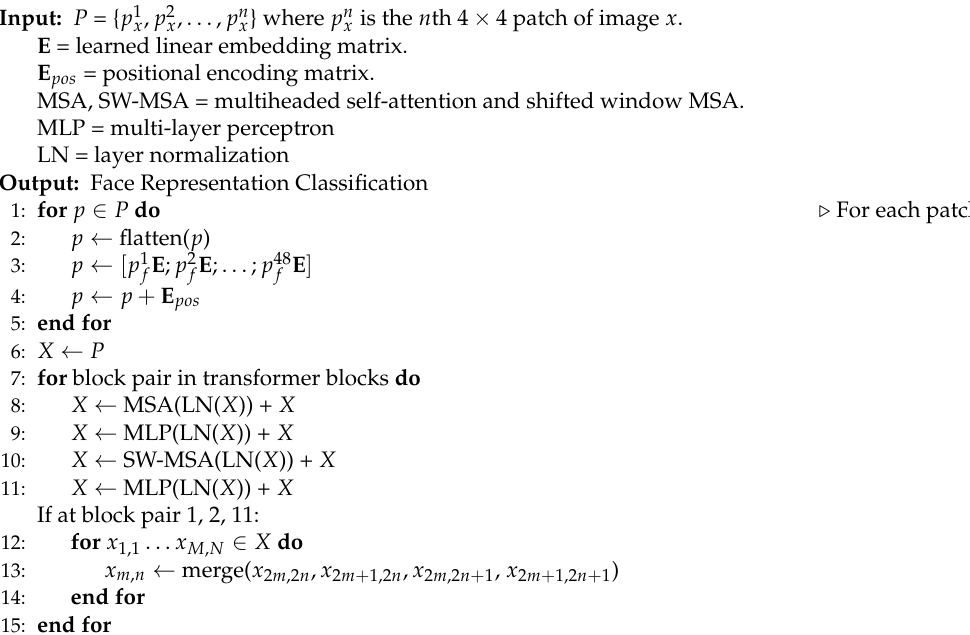
Algorithm 1 Face geometry representation using hierarchical shifted windows